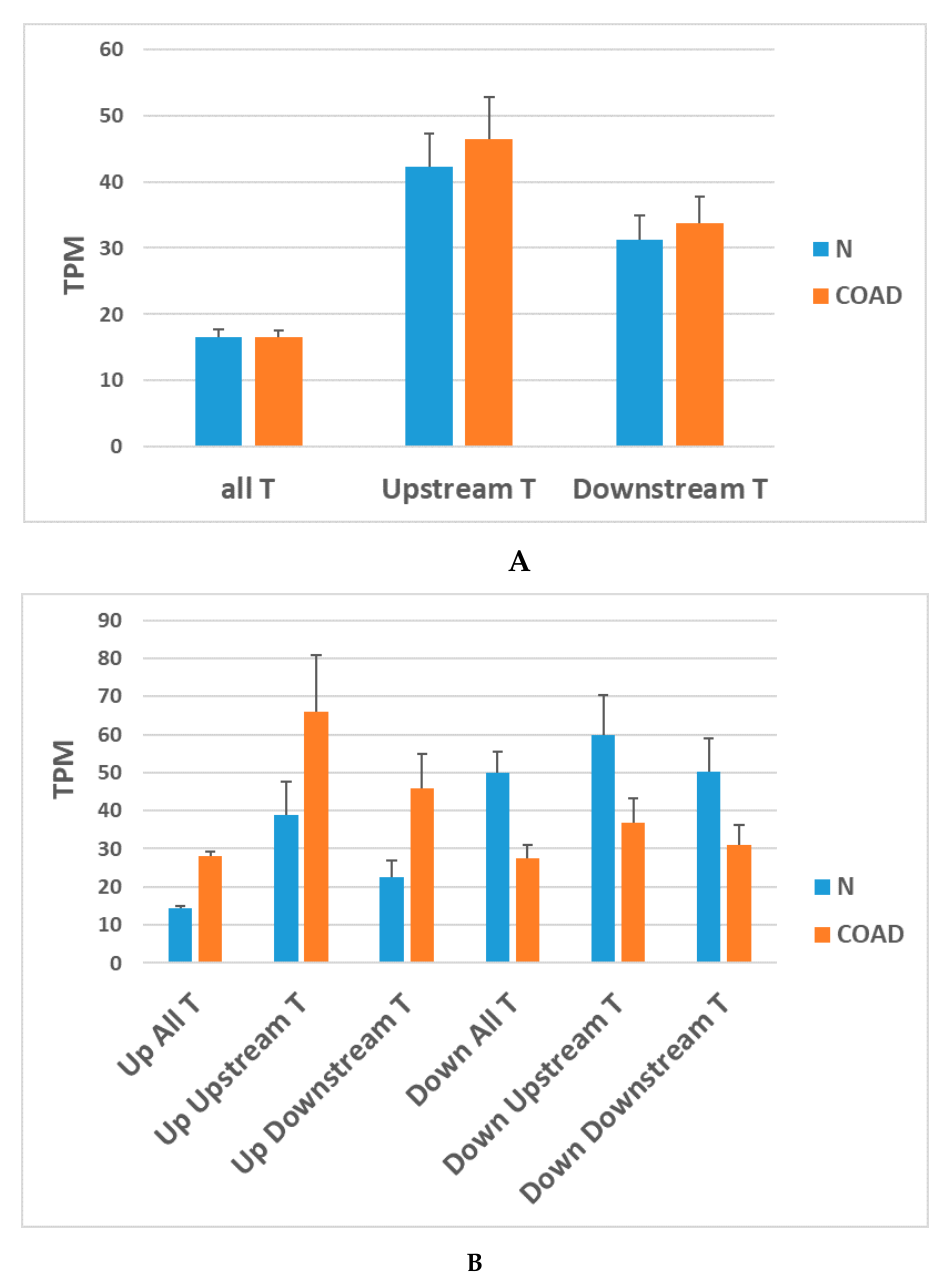
Figure 5. ( A ) Averages ( ± SEM) of TPM values of all transcripts (all T), upstream ConjoinG transcripts (Upstream T), including both the upstream parent gene and the upstream part of the fusion transcript and downstream ConjoinG transcripts (Downstream T), including both the downstream parent gene and the downstream part of the fusion transcript. N: Normal colonic mucosae; COAD: CIN-positive colon adenocarcinomas from TCGA. ( B ) Averages ( ± SEM) of TPM values of all 60,485 analysed transcripts (All T), Upstream transcripts (Upstream T) and Downstream transcripts (Downstream T). Up: Upregulated; Down: Downregulated.